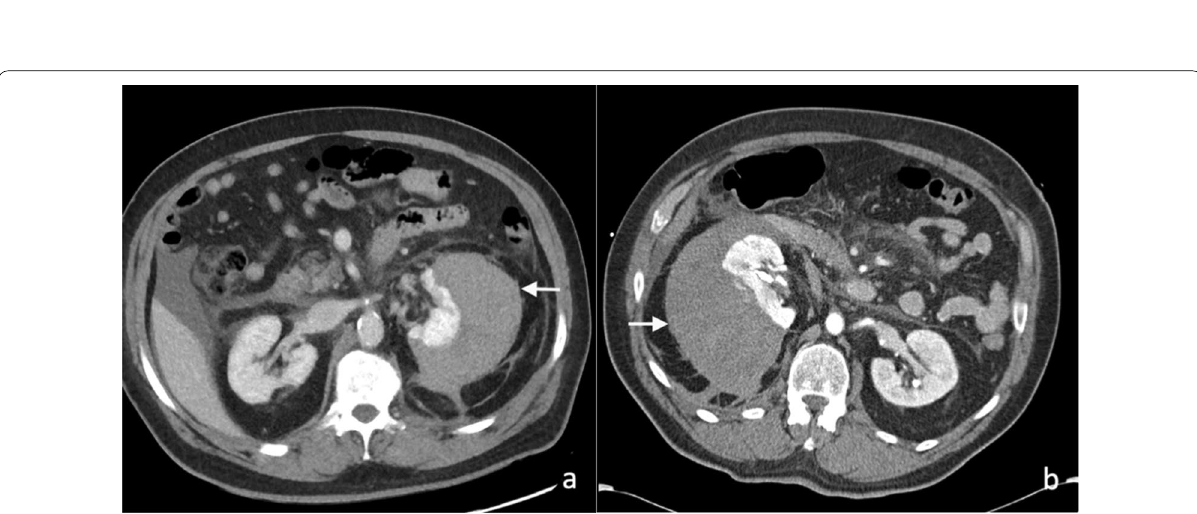
Fig. 6 Axial contrast-enhanced CT images of ( a ) perinephric haematoma (white arrow), and ( b ) subcapsular haematoma (white arrow) post-ESWL in two